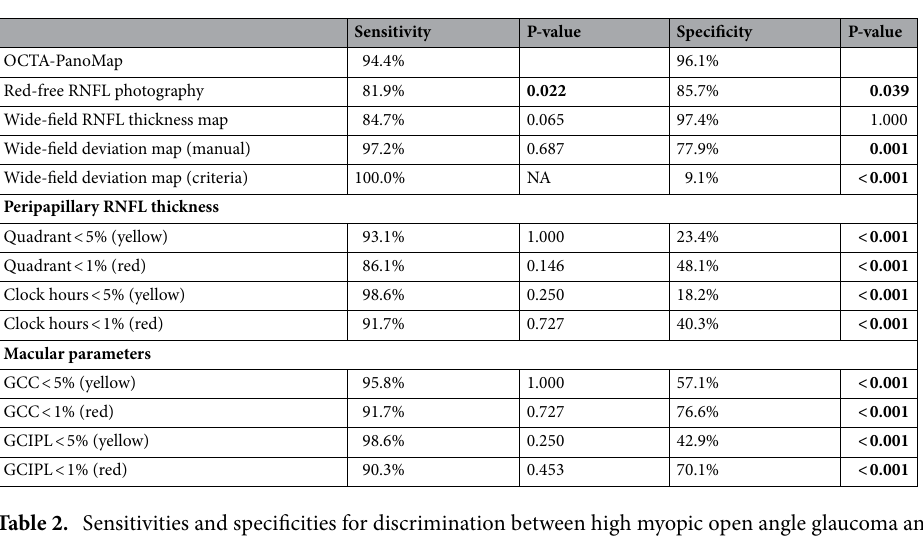
Table 2. Sensitivities and specificities for discrimination between high myopic open angle glaucoma and healthy high myopia. To qualify as “yellow” or “red” was at least 1 sector for the analysis being yellow or red. P value index compared with OCTA-PanoMap (McNemar’s test). Bold values indicate statistical significance with p-value less than 0.05. OCT-A optical coherence tomography—angiography, RNFL retinal nerve fiber layer, GCC ganglion cell complex, GCIPL ganglion cell inner plexiform layer.